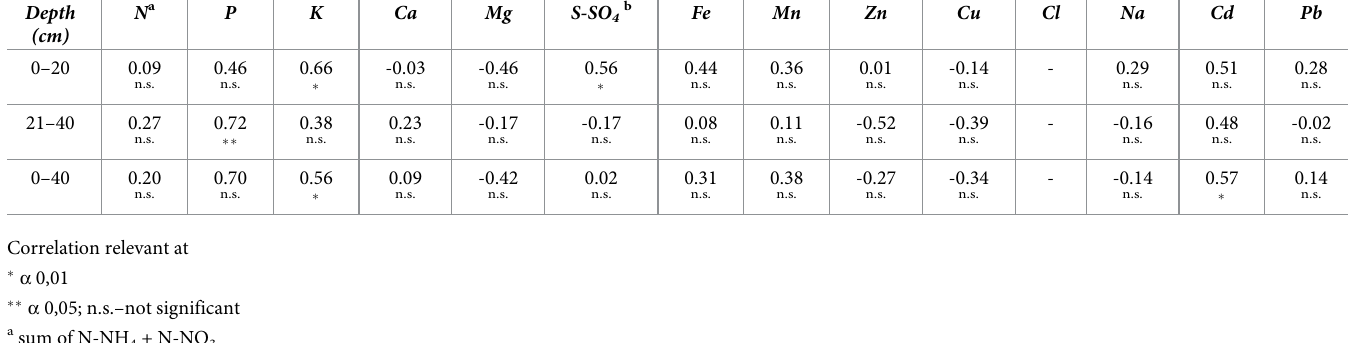
Table 7. Pearson correlation coefficients between the content of macro- and microelements, Na and heavy metals in the soil and in horse chestnut tree leaves. Depth N a P K Ca Mg Pb (cm)